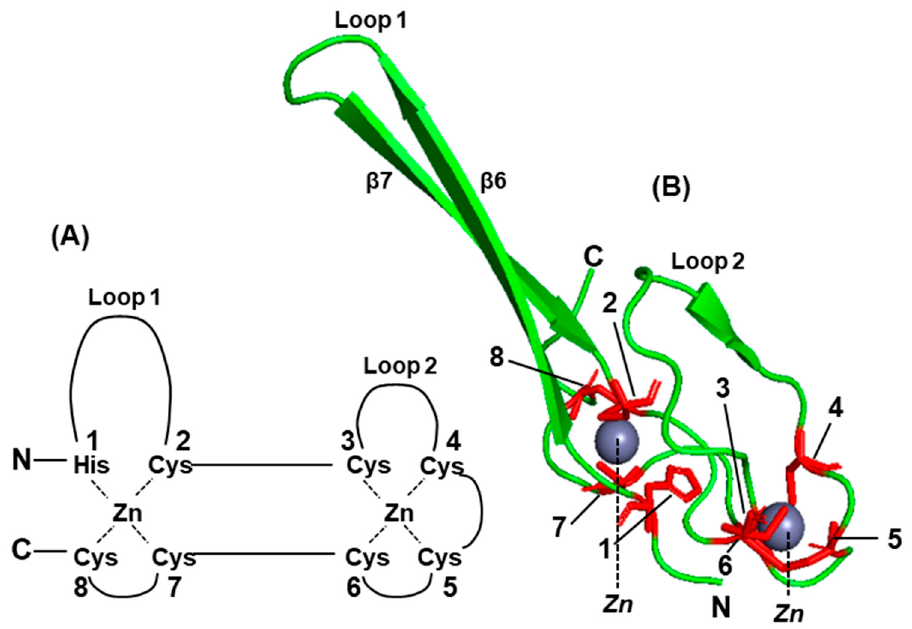
Figure 5. The structure of the zinc finger at the C-terminal domain (CTD) of the Paramyxoviridae V proteins. A consensus schematic ( A ) and the actual crystal structure of SV5 V protein zinc finger [105] in PyMol presentation ( B ) are shown. The eight residues participating in the coordination of zinc are numbered (and in Figure 4); the two intervening loops (large loop, L1; small loop, L2) and the zinc ions (gray spheres in panel ( B ); they are red spheres in Figure 6, panel ( A )) are also indicated. The two beta-strands of the L1 loop ( β 6, β 7) are marked. Note that in the jeilongviral V proteins critical zinc-coordinating residues (viz. residue #5, #6, #7, and #8 in all three viruses, and also residue #1 in JPV; Figure 4) were replaced by non-coordinating residues, and consequently, they cannot form a zinc finger.